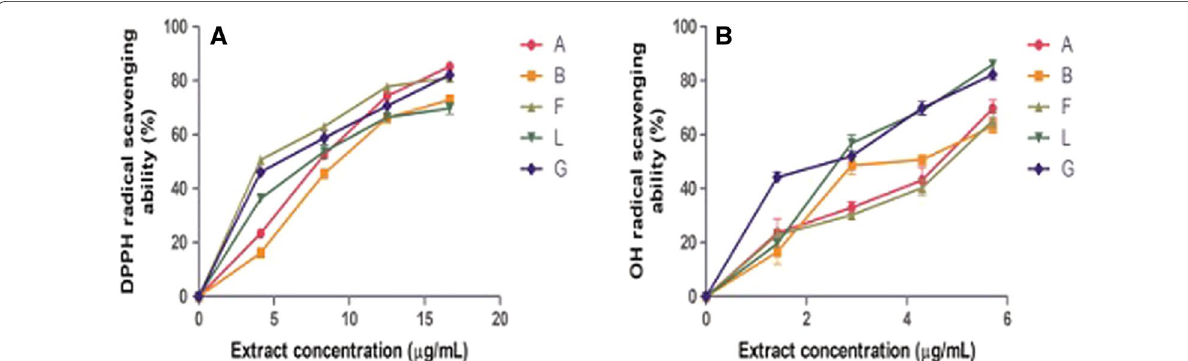
Fig. 1 Antioxidant Activities of corn silk–lemon and commercial tea infusion. A DPPH radical scavenging activities using spectrophotometric method reported by Gyamfi et al. (1999). The absorbance of the mixture prepared from dilution of the infusion and solution containing DPPH radical was read at 516 nm. The percentage DPPH radical scavenging ability of the extracts was calculated as percentage of control. The percent DPPH radical scavenging ability was plotted against five samples extract concentration (ug/ml). B Hydroxyl radical scavenging activities as described by Halliwell et al. (1987) and tis was used to determine the ability of the extracts to prevent Fe 2 /H 2 O 2 induced decomposition of + deoxyribose. Spectrophotometer was used to take the absorbance reading of the solution prepared from the mixture of the extracts (0–200 µl) and reaction mixture. The percent hydroxyl radical scavenging ability was plotted against five samples extract concentration (ug/ml). CSF: corn silk flour;